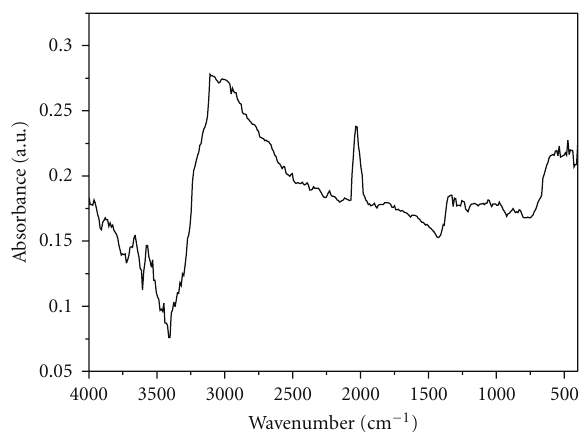
Figure 1: IR spectrum corresponding to functionalized